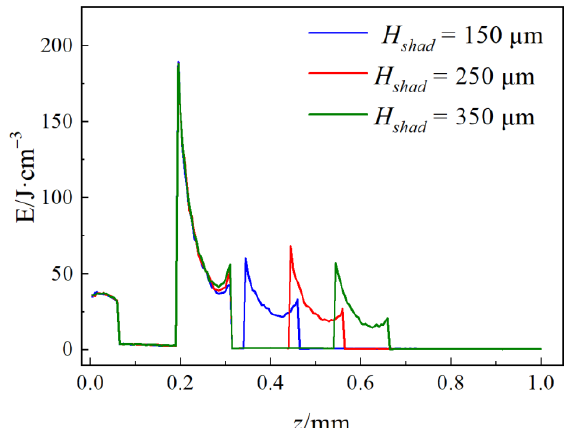
Figure 11. Line graph of energy deposition vs. depth at the beam center for simulations of skin with parallel blood vessels with different H shad values at θ shad = 90°.